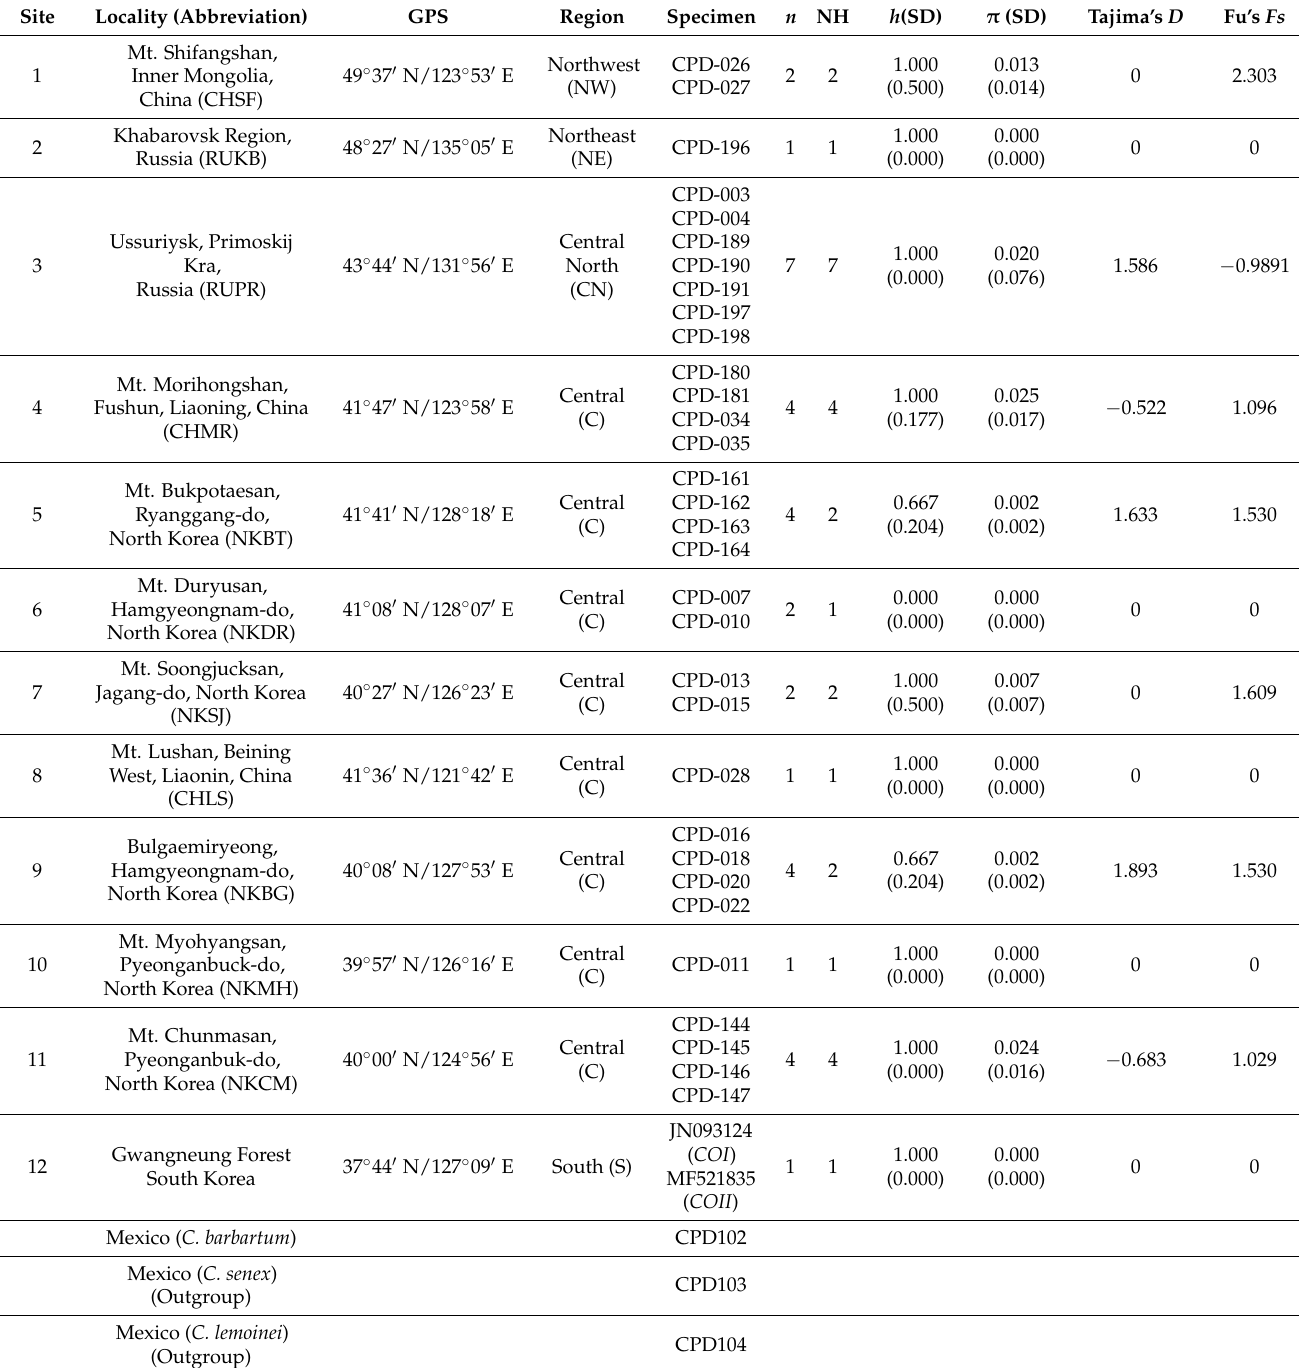
Table 1. Collection and voucher information, and genetic indices of C. relictus samples used for DNA analysis (see Figure 2). Significant values ( p < 0.05) are indicated in